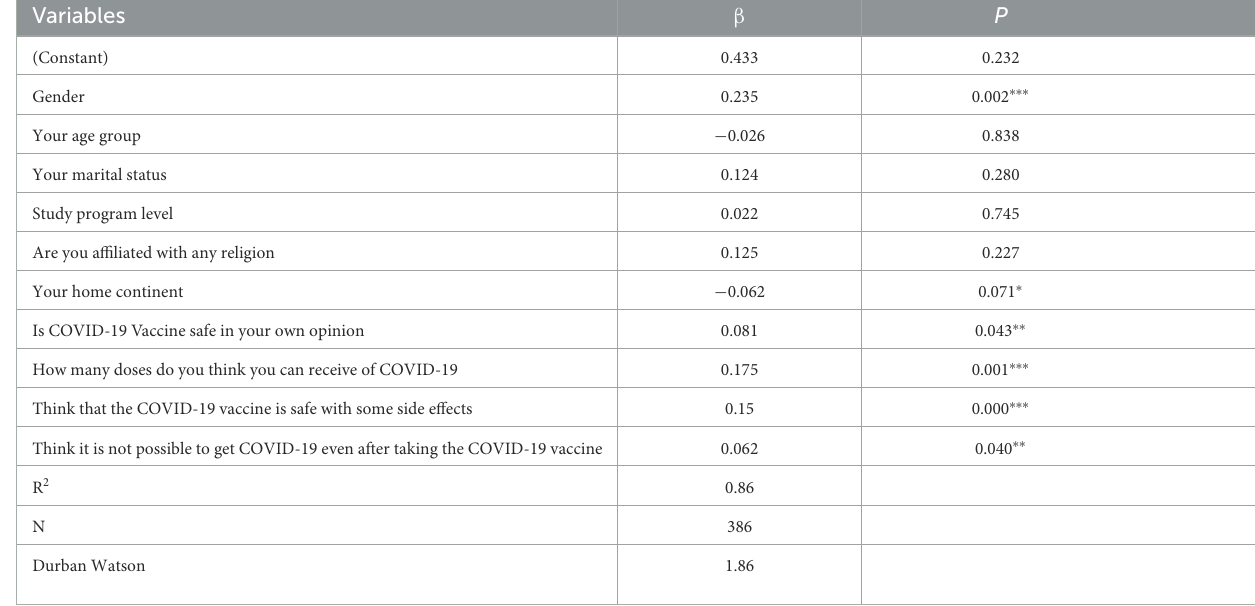
TABLE 3 Factors associated with COVID-19 vaccine acceptance among foreign medical students in China using a multilinear regression